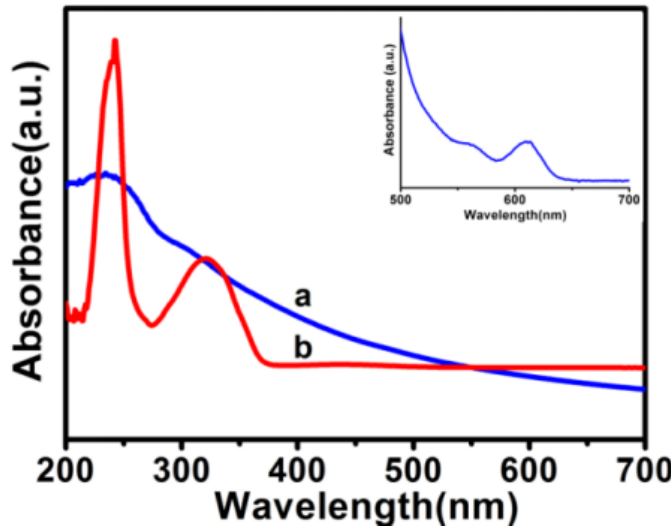
Figure 9. UV-vis absorption spectra of pristine GO ( a ), QDs/polymer/GO fluorescence nanohybrid ( b ) and CdSe/ZnS QDs (inset).